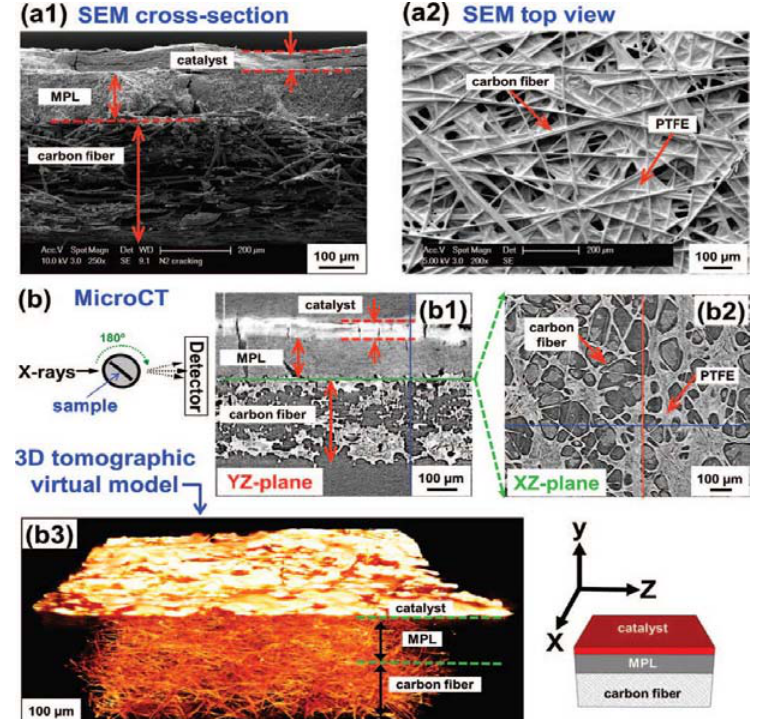
Figure 6. Comparison of the information obtained by traditional SEM cross-section analysis and micro-computed tomography. Reprinted with permission from [34]. Copyright 2012, The Electrochemical